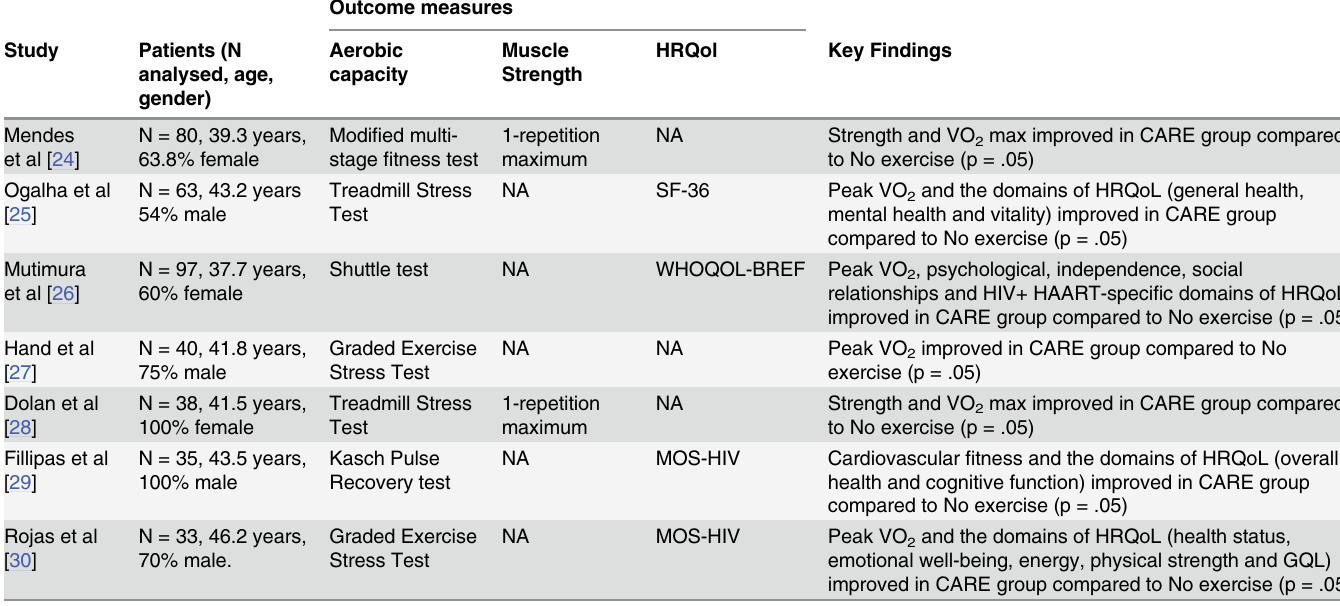
Parameters used in the application of CARE have been reported in most studies, and all described the progressive nature of the exercise training. The characteristics of exercise inter- vention in included studies are provided in Table 4. Table 3. Characteristics of the included studies.